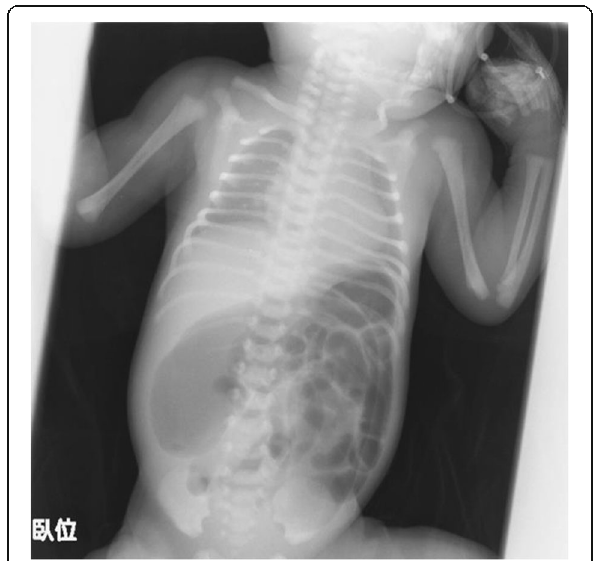
Fig. 1 Plain abdominal radiography (36 h after birth). Plain